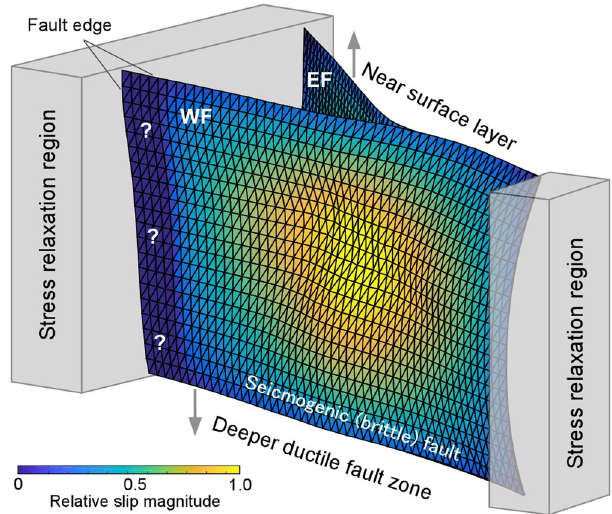
Fig. 5 Estimated fault plane and stress relaxation regions at the horizontal edges and extensions. The fault planes are shown at ~3× magni fi cation in the direction perpendicular to the fault strike. Triangular subfaults used in stress and displacement calculations are shown with the assumed slip distribution, which increases from blue to yellow coloured subfaults. For the WF, the case of the northern edge of Y = 6.1 km is shown; however, this value was not well estimated and is possibly located at either location in the portion shown by dark blue. The fault planes are also bounded by the near-surface (inelastic) layer and the deeper ductile fault